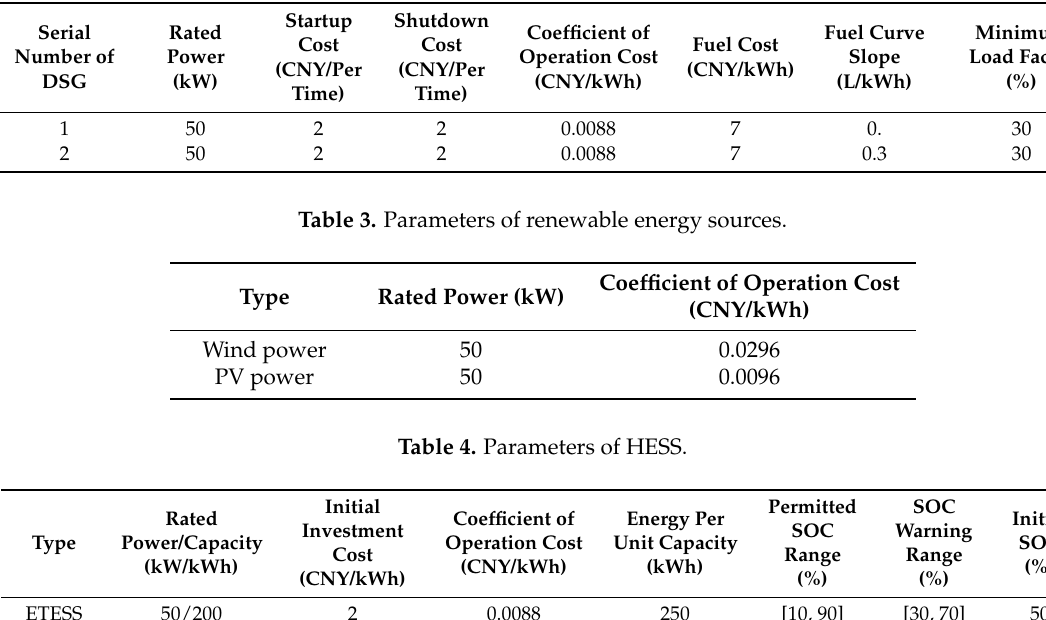
Table 2. Parameters of diesel generator.